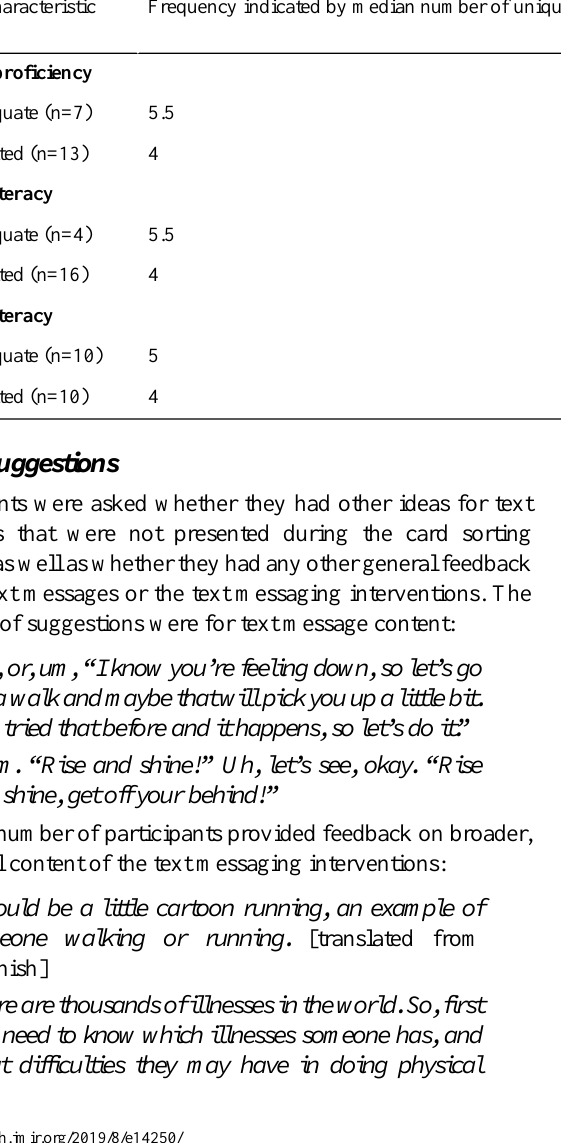
Table 3. Frequency and extensiveness of the feedback on existing text messaging content by English proficiency, health literacy, and digital literacy. (%)Frequency indicated by median number of unique feedbackPatient characteristic English proficiency